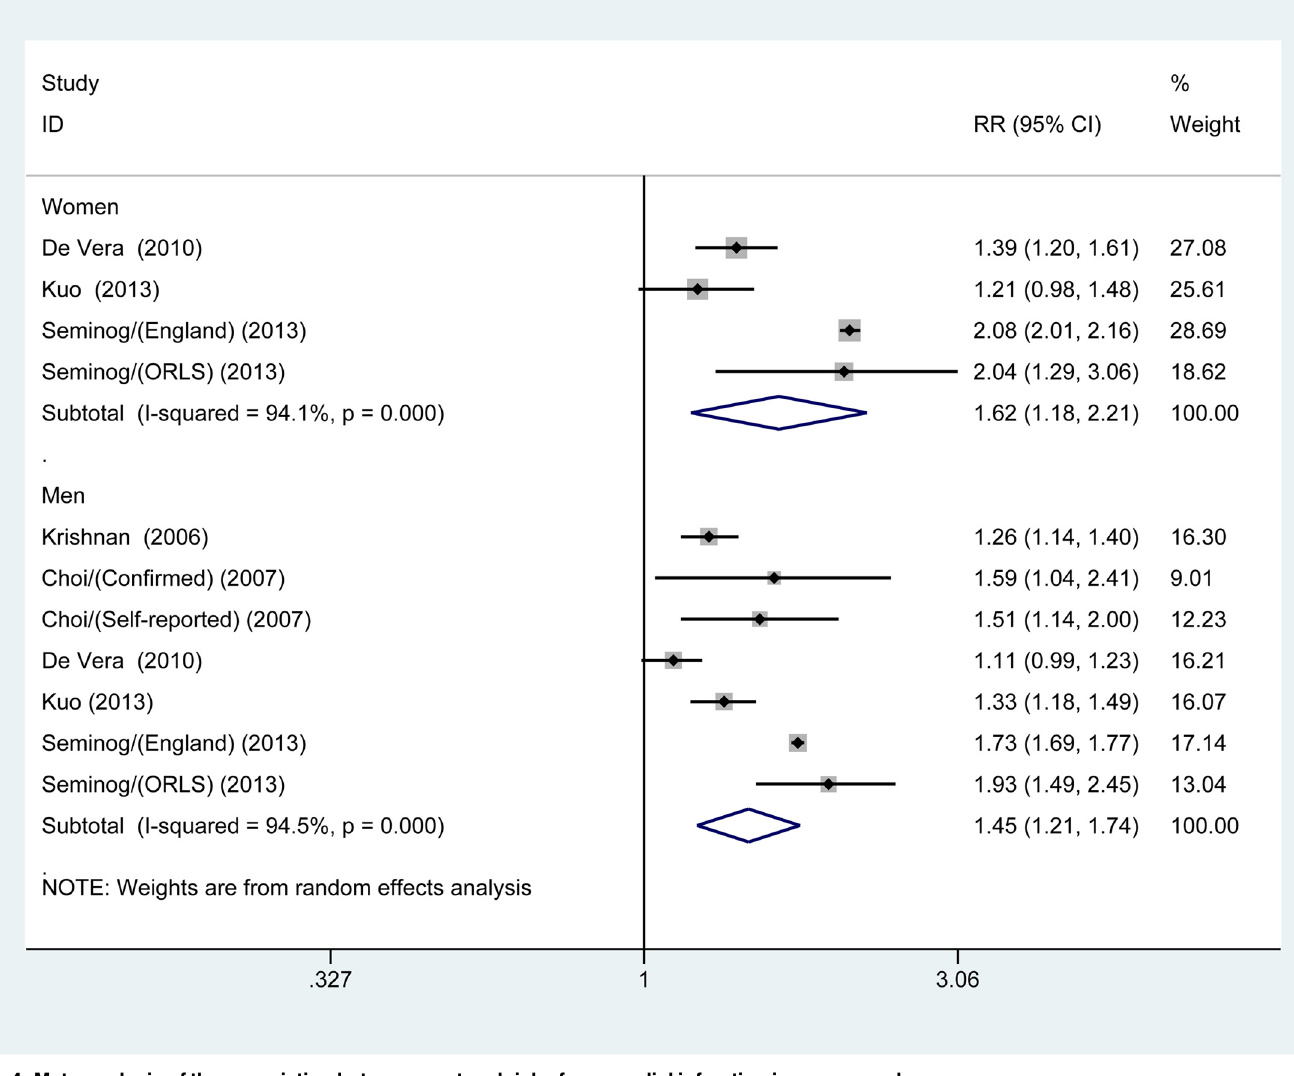
Fig 4. Meta-analysis of the association between gout and risk of myocardial infarction in women and men.